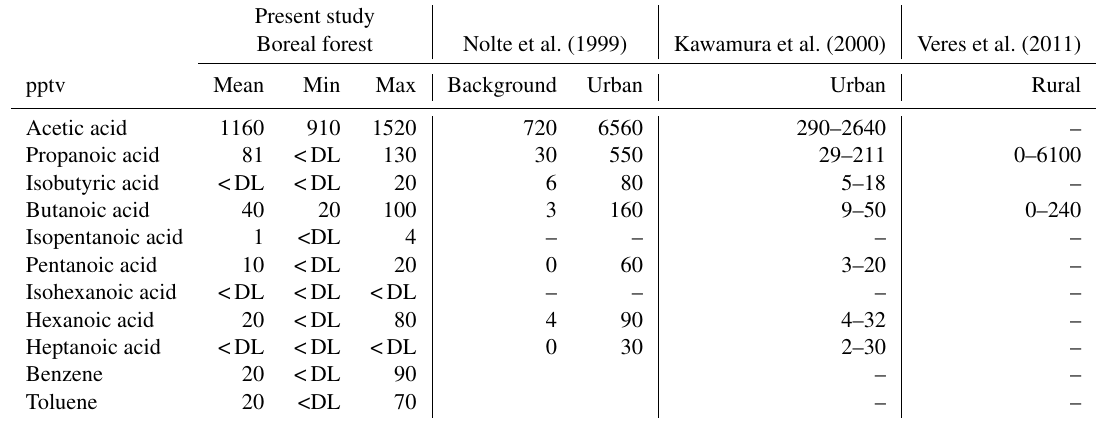
Table 3. Mixing ratios (pptv) of volatile organic acids at SMEAR II station in Hyytiälä, Finland, between 11 and 27 June 2015 and in earlier studies.